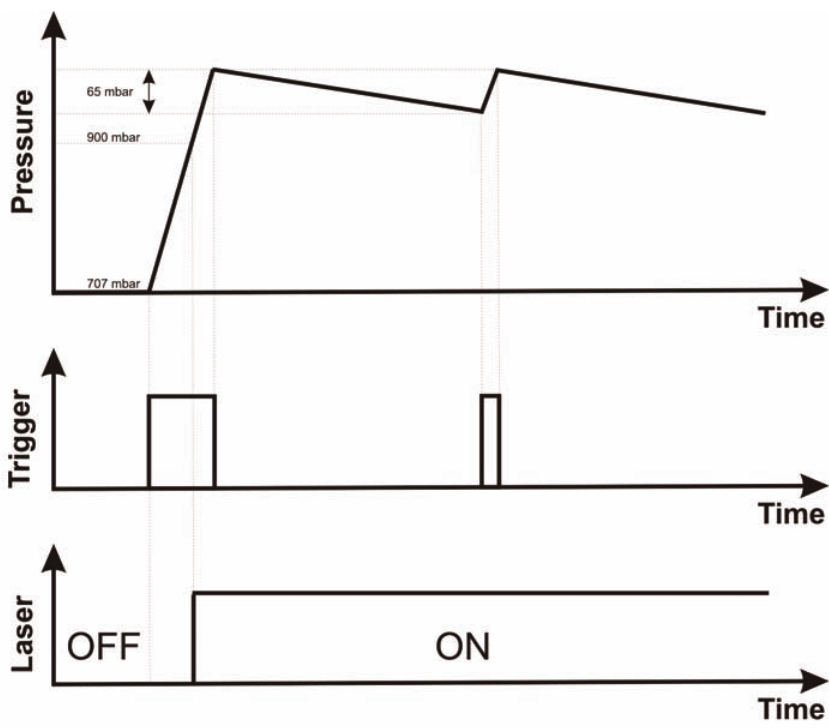
Figure 5. Waveforms of the internal pressure of the chamber (a), the signal to drive the 12 V compressor (b), and the activation of the laser (c).